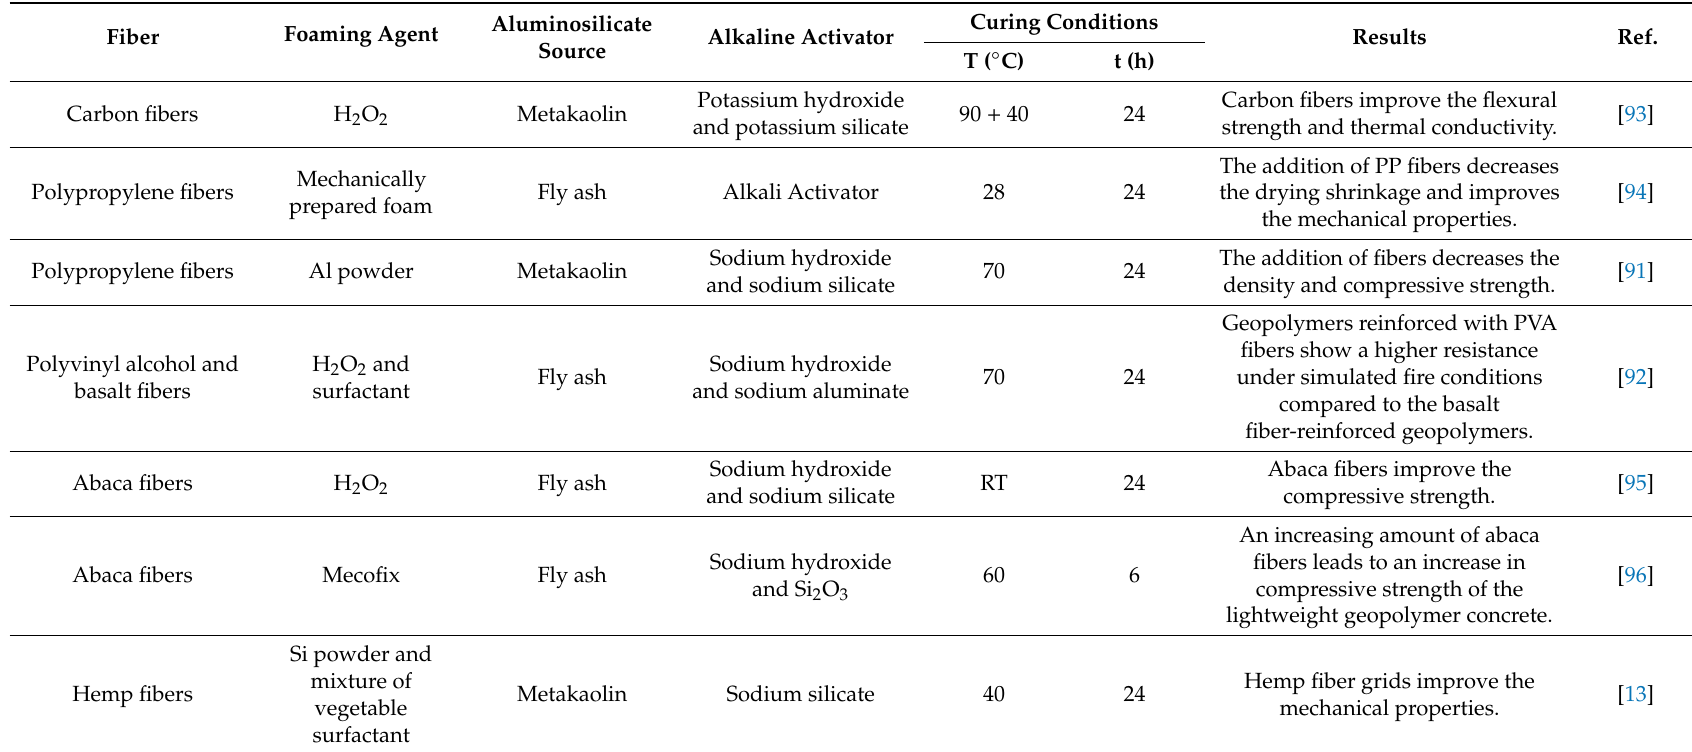
Table 3. Overview of fiber-reinforced geopolymer foam